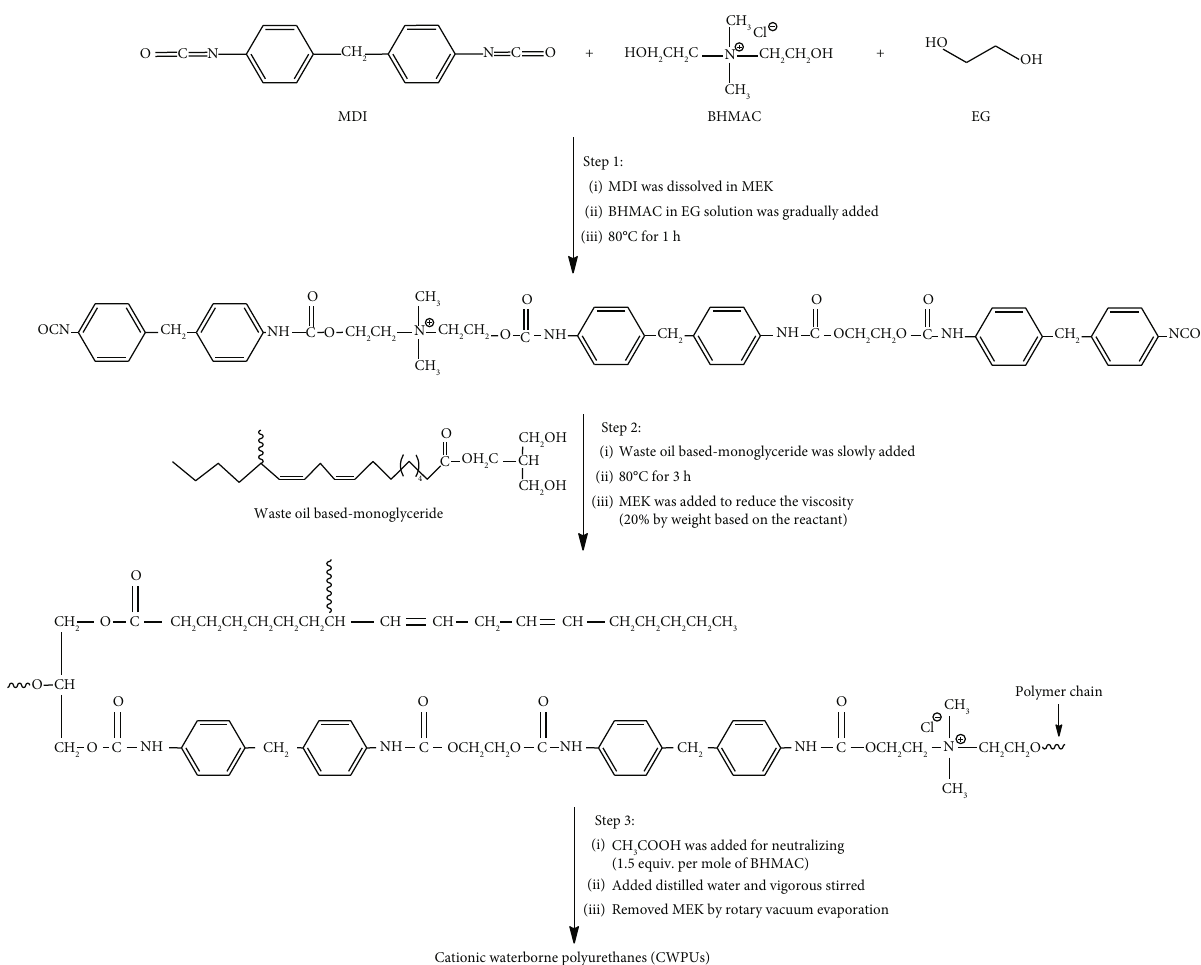
Scheme 1: Synthesis of cationic waterborne polyurethanes (CWPUs).